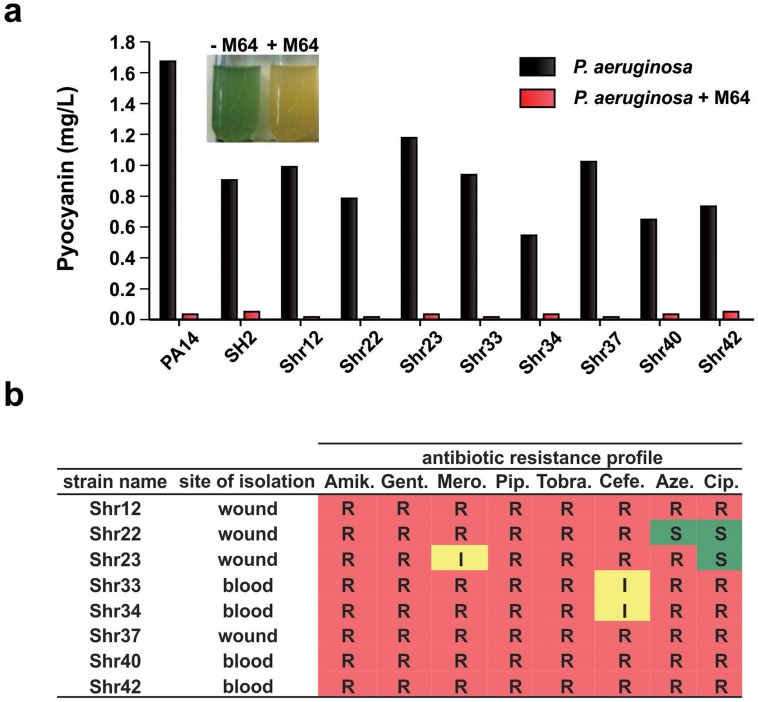
M64 reduces pyocyanin production in P. aeruginosa clinical multi-drug resistant strains.
a. Quantitative pyocyanin production in multi-drug resistant clinical P. aeruginosa isolates plus (red) and minus (black) 5 µM M64. A representative image of qualitative pyocyanin production, visible as green media, in PA14 culture +/− M64, is shown above the histogram. b. Antibiotic resistance profile of P. aeruginosa clinical strains and their respective isolation sites from infected patients. Amik. = amikacin, Gent. = gentamycin, Mero. = meropenem, Pip. = piperacin, Tobra. = tobramycin, Cefe. = cefepime, Aze. = azetromycin, Cip. = ciprofloxacin. R = resistant; I = intermediate; S = sensitive.